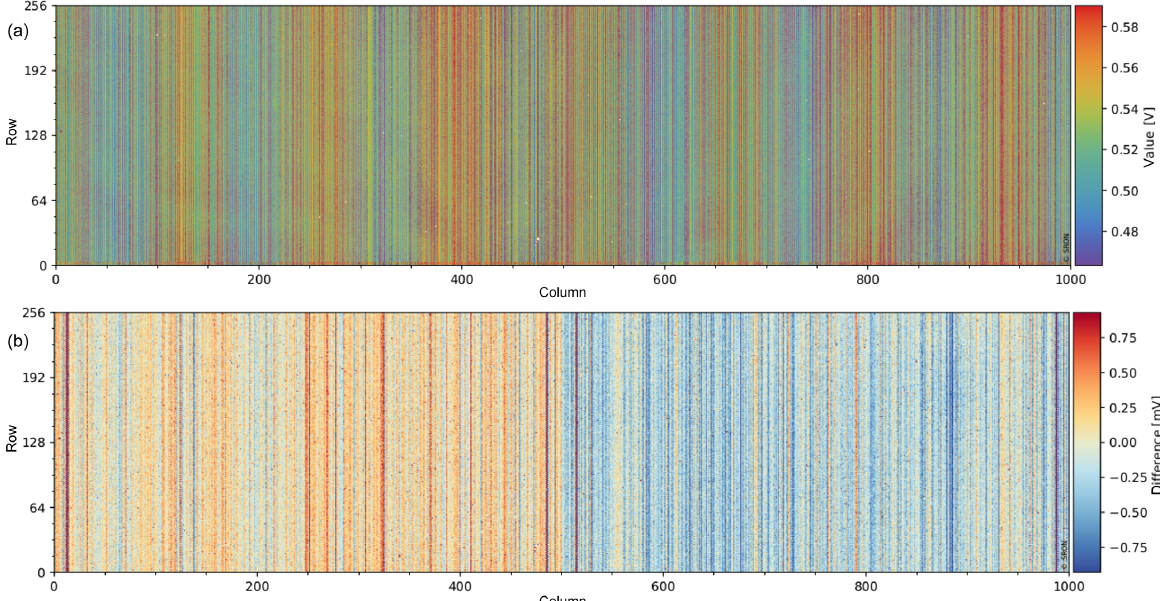
Figure 8. The offset obtained with the FMM closed during the E1 phase using data from orbits 2707 to 2721 can be seen in panel (a) . Data are plotted over the detector with the horizontal axis equivalent to the spectral direction and the vertical axis equivalent to the spatial swath. A comparison to the offset derived during the ground-based calibration is shown panel (b) .